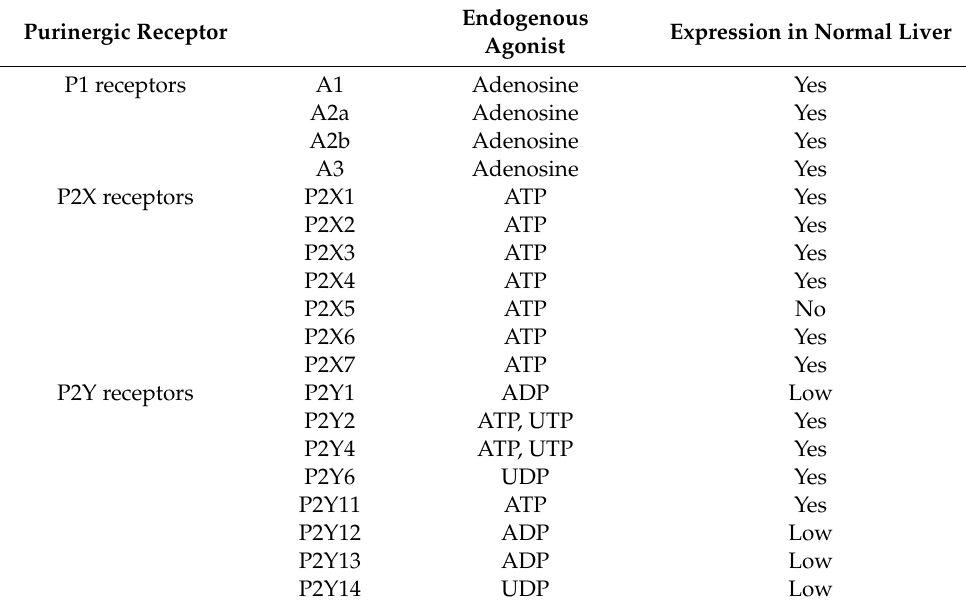
Table 1. Classification of purinergic